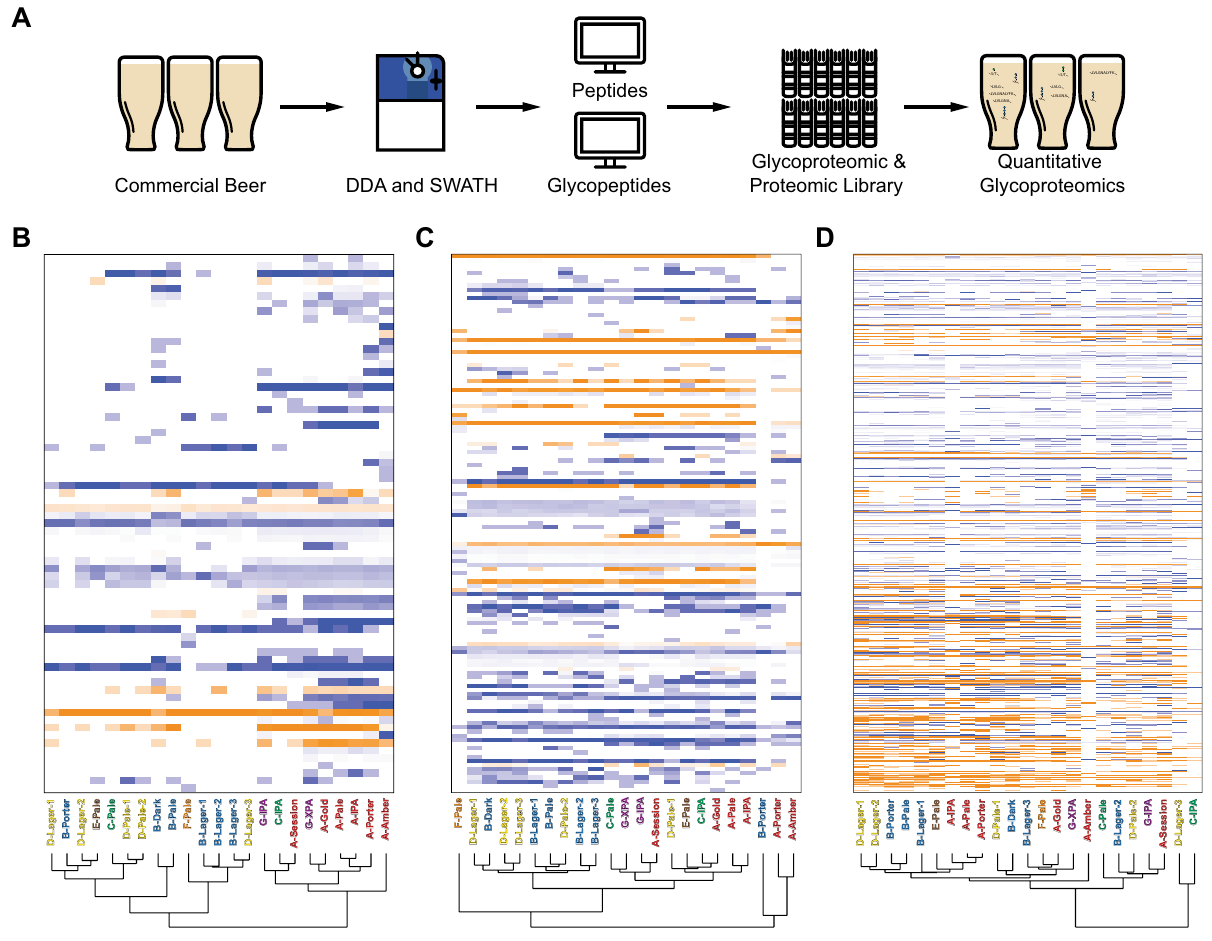
Figure 1. Site-specific glycosylation, glycation, and proteolysis differentiate beer proteomes. ( A ) Overview of the workflow for identification, measurement, and site-specific analysis of modified and unmodified peptides for quantitative glyco/proteomics. Clustered heat map of normalised site-specific ( B ) glycosylation, ( C ) glycation, and ( D ) proteolysis. Modified peptides were normalised to their peptide family. Unmodified peptides shown in orange, modified forms shown directly below in blue. Dendrograms show sample clustering by brewery ( A–G ) and beer style. Heatmaps use log 10 protein abundance normalised to total protein abundance in each